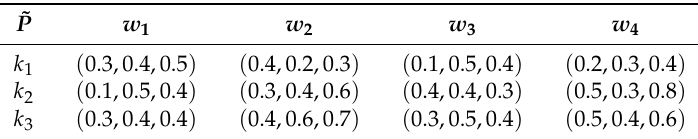
Table 4. Neutrosophic soft relation ˜ P